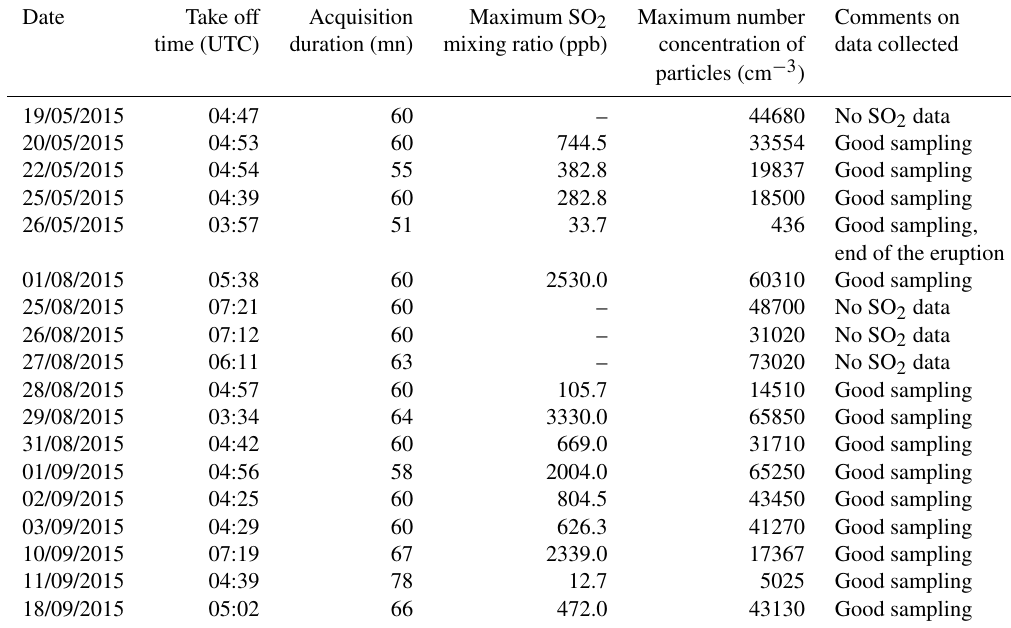
Table 2. Summary of flights made by the ultralight aircraft during the volcanic ash events of May–September 2015. Date